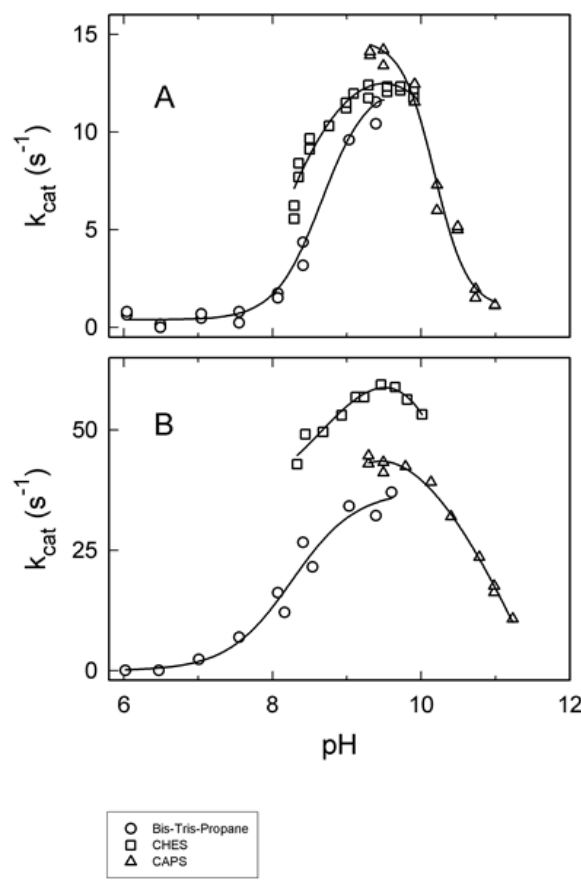
Figure 3: Buffer effect for the glutamate + 3-phosphohydroxypyruvate -> 2-oxoglutarate + phosphoserine reaction of PSAT-BALC (A), and PSAT-BCIRA (B). The PSAT reaction mixture contained 100 mM Bis-Tris-propane (○), CHES (□), and CAPS (∆); in 250 mM NaCl, 20 µM PLP,and 0.2 µg enzyme. The reaction was stopped after 3 min by changing pH to 6.1 with 1 M MES. 2-Oxoglutarate produced by PSAT was measured with the GlDH reaction. The points are the experimental, while the lines are fitted with the Sigma Plot program (version 6, Jandel Scientific